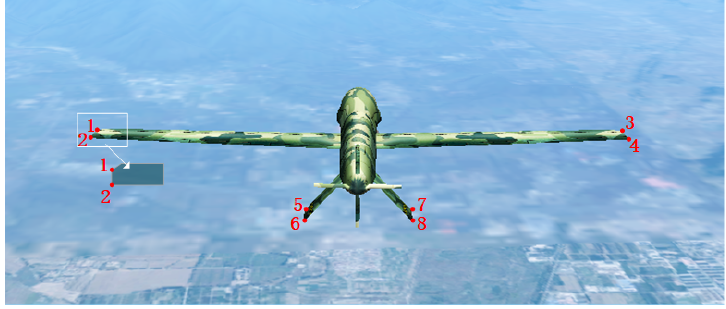
Figure 15. Aircraft attitude measurement keypoints.